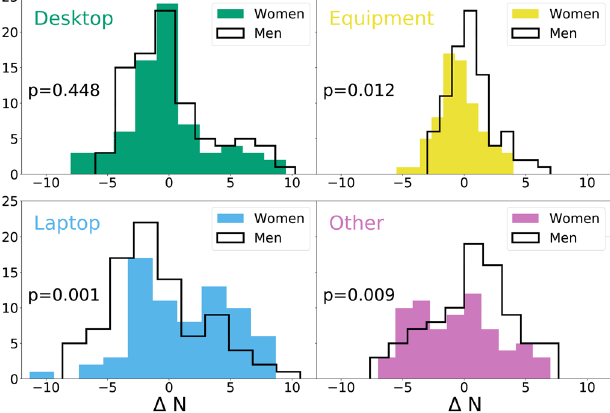
FIG. 9. Histograms of intragroup deviations for men and women within the inquiry lab ’ s mixed-gender groups for the desktop, equipment, laptop, and other behavior codes, with the y axis representing the number of student profiles. Each student deviates from their group ’ s average by Δ N [defined in Eq. (A2) in Materials and Methods A]. A positive Δ N denotes a student engaging in a behavior more often relative to their group members. We quote p values calculated from the Mann-Whitney U test statistic on all plots and find significant differences between men and women for the laptop and other codes. We also find a borderline result of men handling the equipment more than their group exceeding the p ¼ 0 . 01 cutoff, with p values ranging from p ¼ 0 . 03 – 0 . 9 ). The comparable intragroup variances sig-